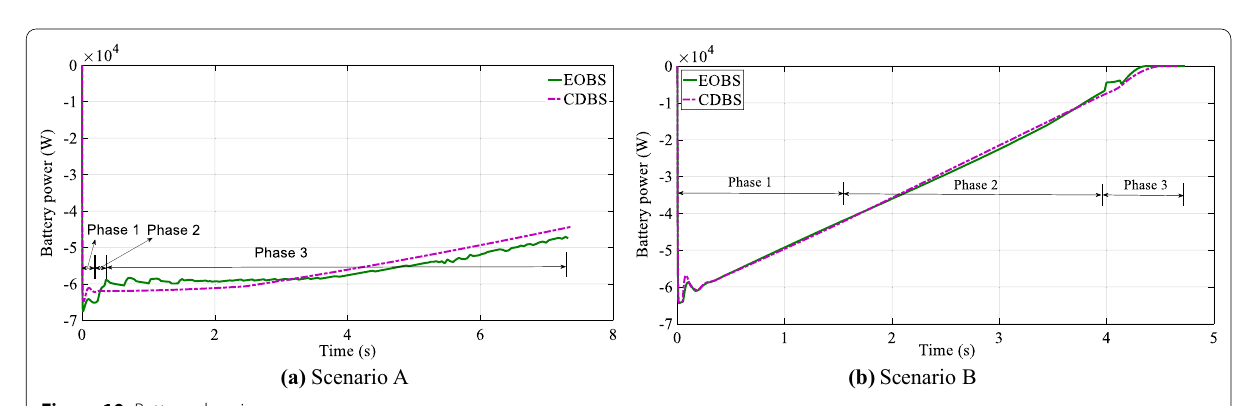
Figure 10 Battery charging power